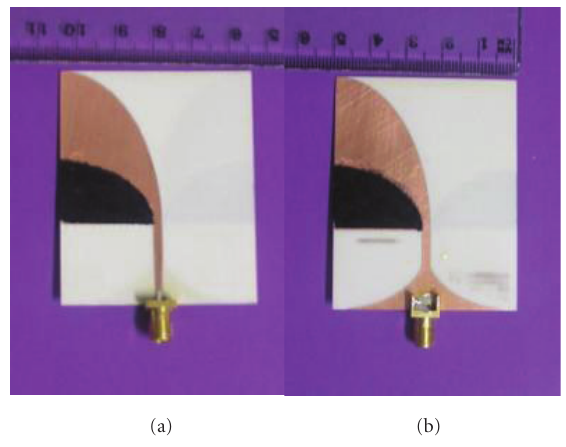
Figure 3: Photo of the developed antenna: (a) top view, and (b) bottom view.